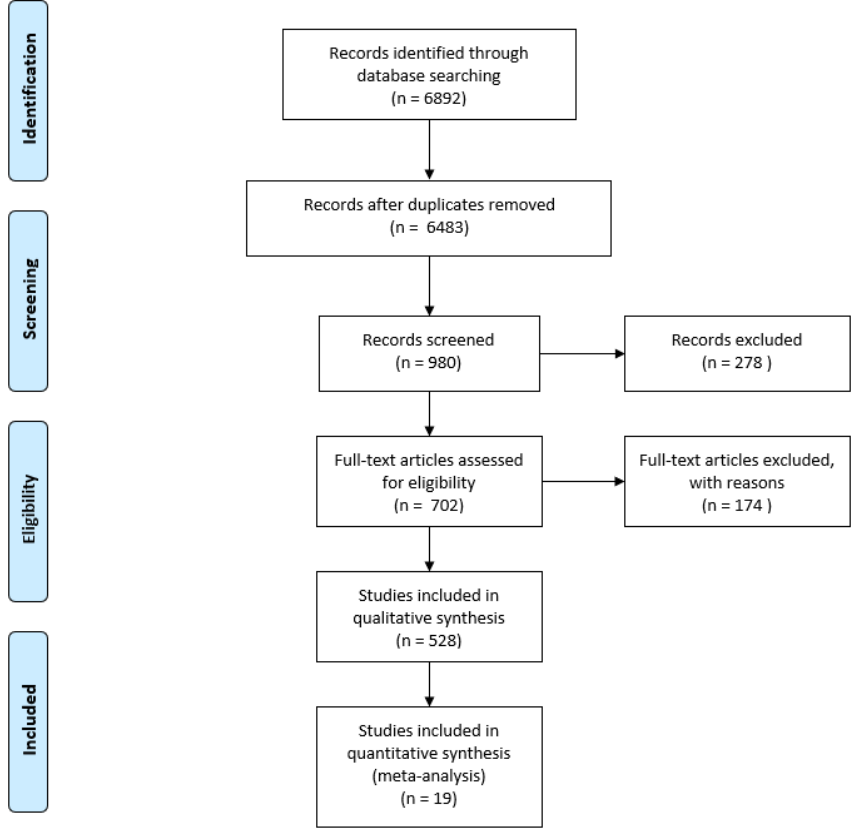
Figure 1. PRISMA flow diagram.